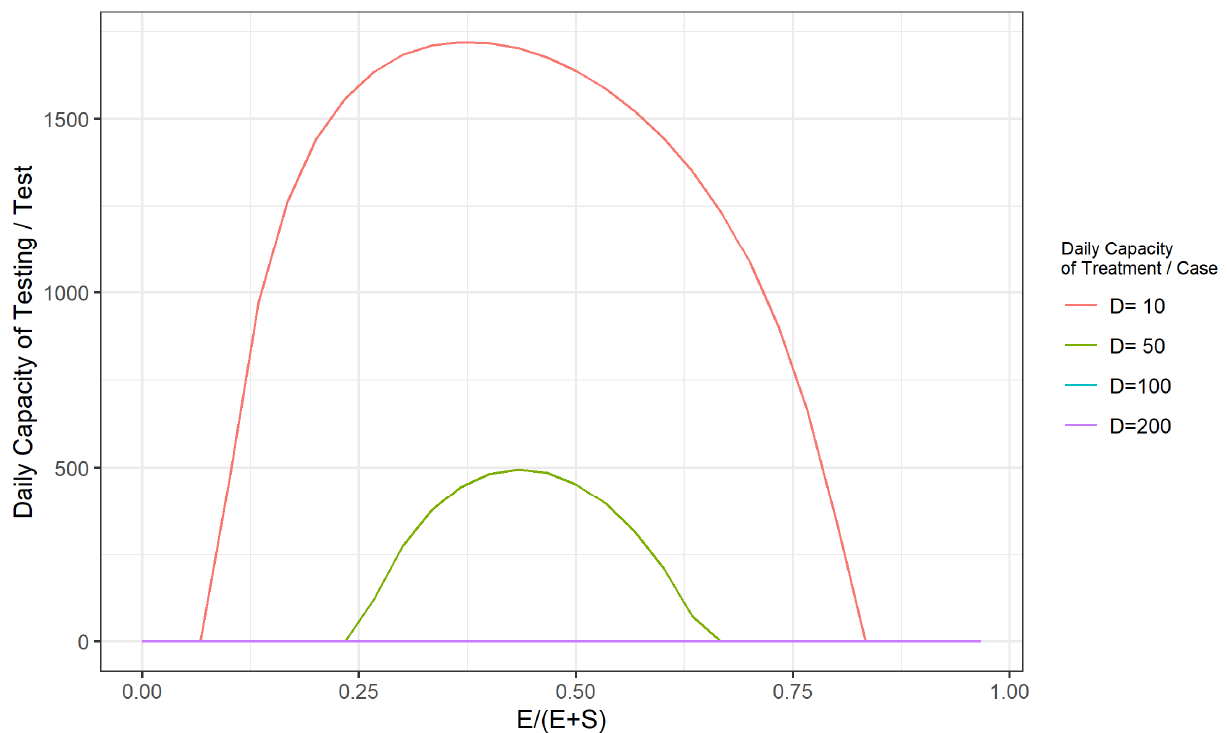
Figure A10. The effect of daily testing capacity on the ability to control the potential development level of the epidemic ( S + E = 5000, I = 1000).